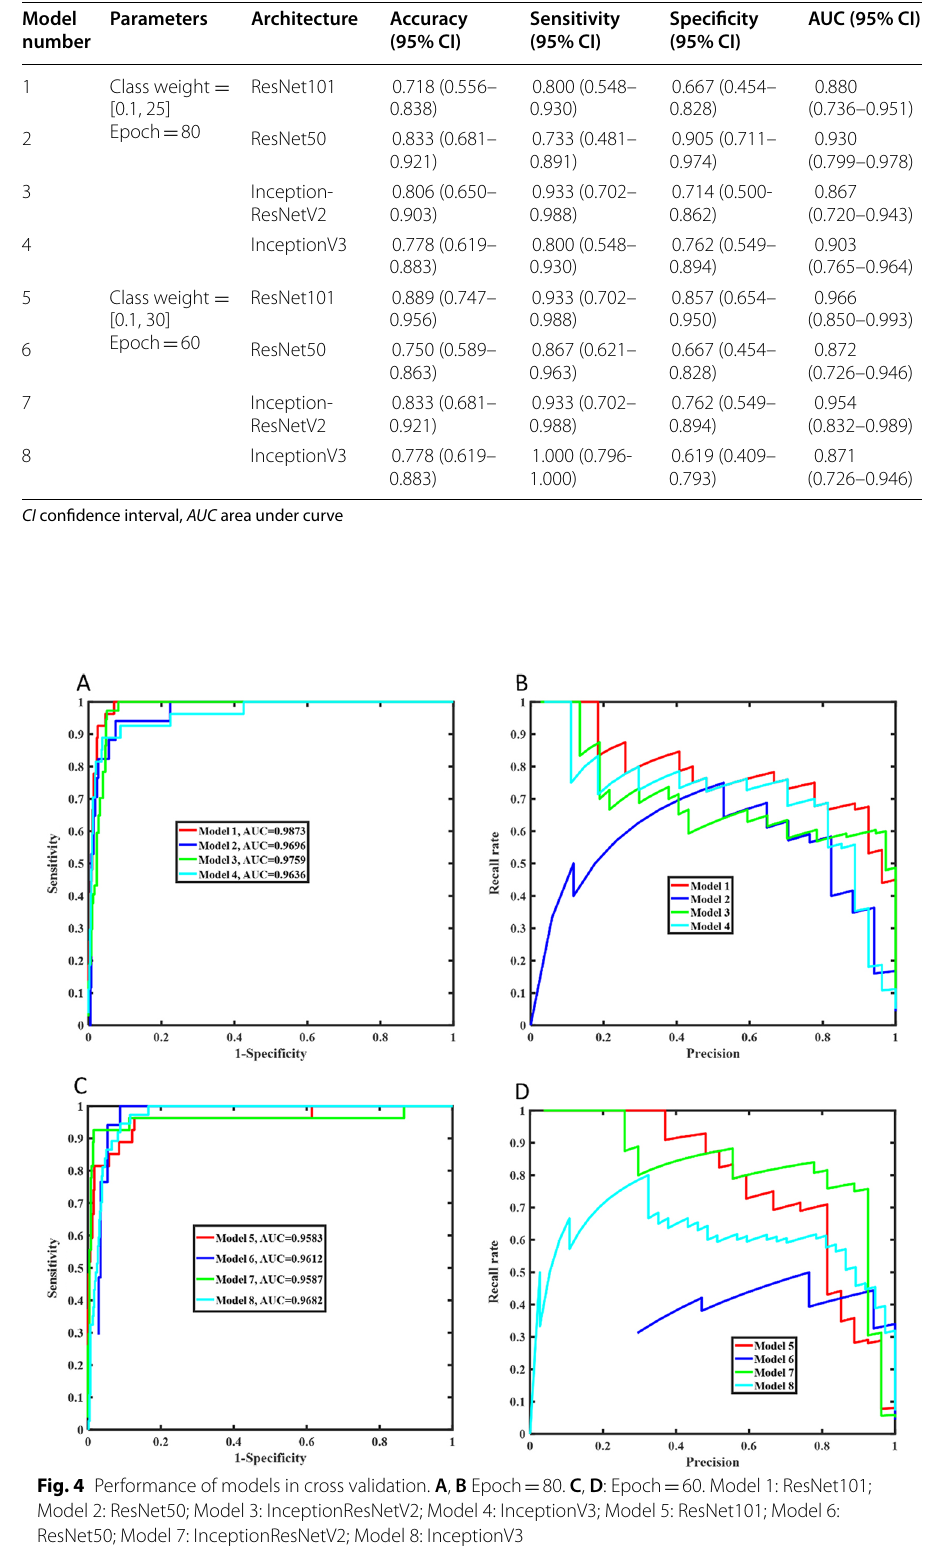
Table 3 Performance of models in the prospective validation dataset